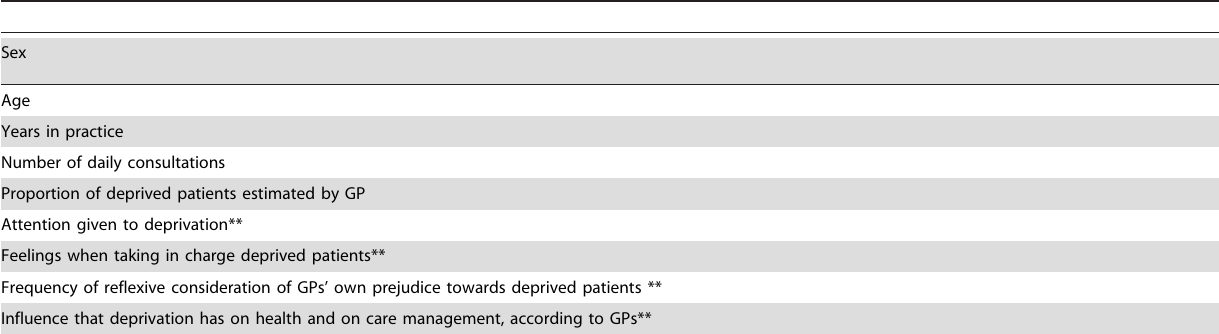
Table 2. Potential GP level correlates of GP’s perception of patient social